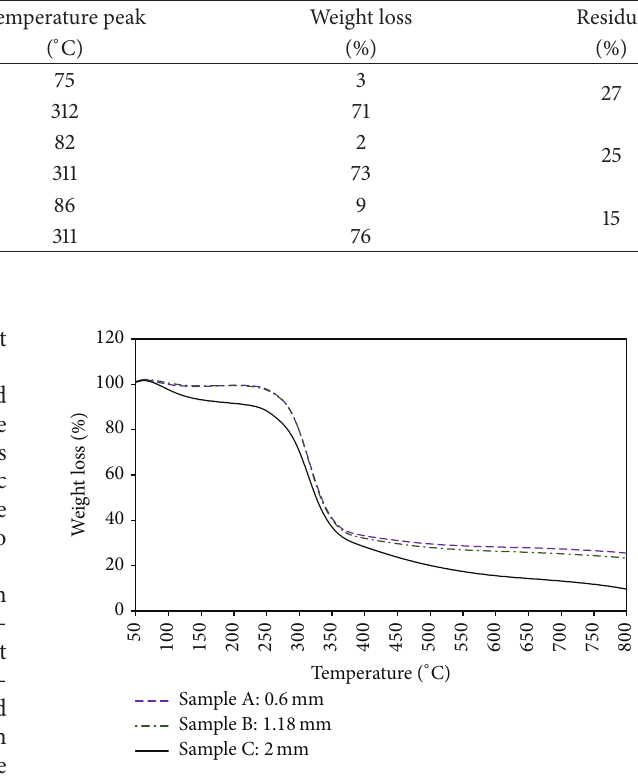
Table 1: Results for Sago/UF Sample with different particle size analysis by TGA.